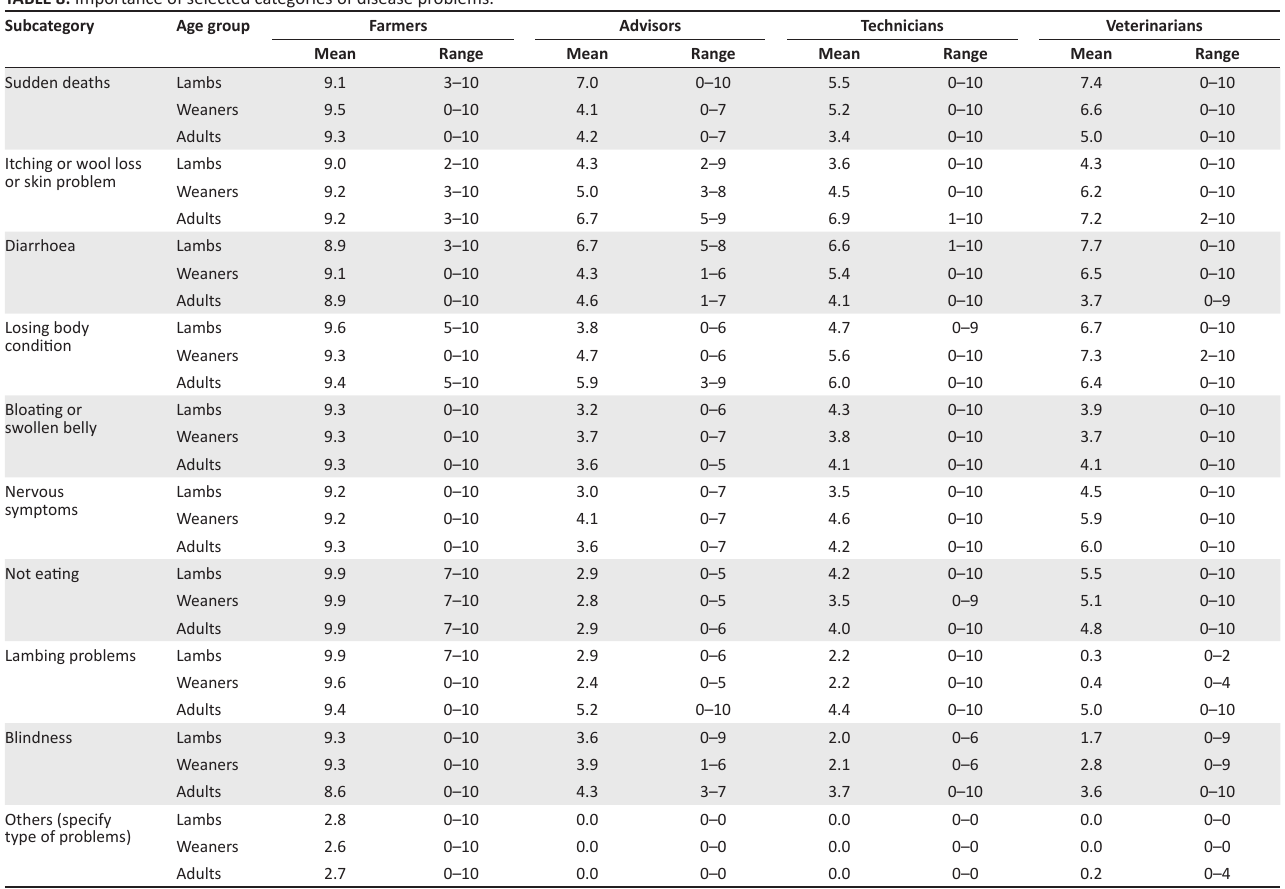
TABLE 8: Importance of selected categories of disease problems. Subcategory